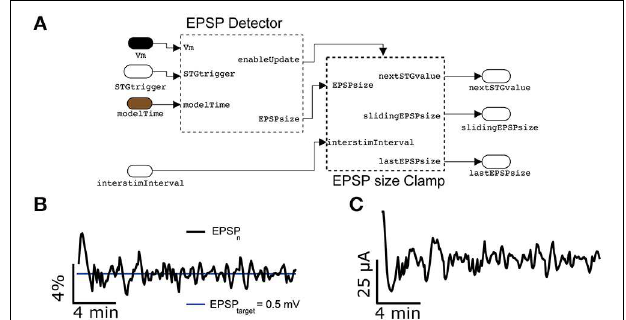
FIGURE 9 | Synaptic response clamp. Further generalizing the experimental protocol of Figure 7 to electrically evoked synaptic responses, measured postsynaptically by an intracellular access to the neuron, the intensity of the peak compound evoked Postsynaptic Potential (PSP) can be automatically regulated by a PI controller (A) , provided in our Library. In this case, thanks to the EPSPsizeClamp module, the evoked PSP peak amplitude can be constrained to a desired value of 0.5mV with a tolerance of less than 4% (B) , while adapting in real time the intensity of the extracellular stimulation (C) . Commonly used parameter values were P pid = 1 , I pid = 0 . 3 , G = 1 ′ 600 , τ = 300 s